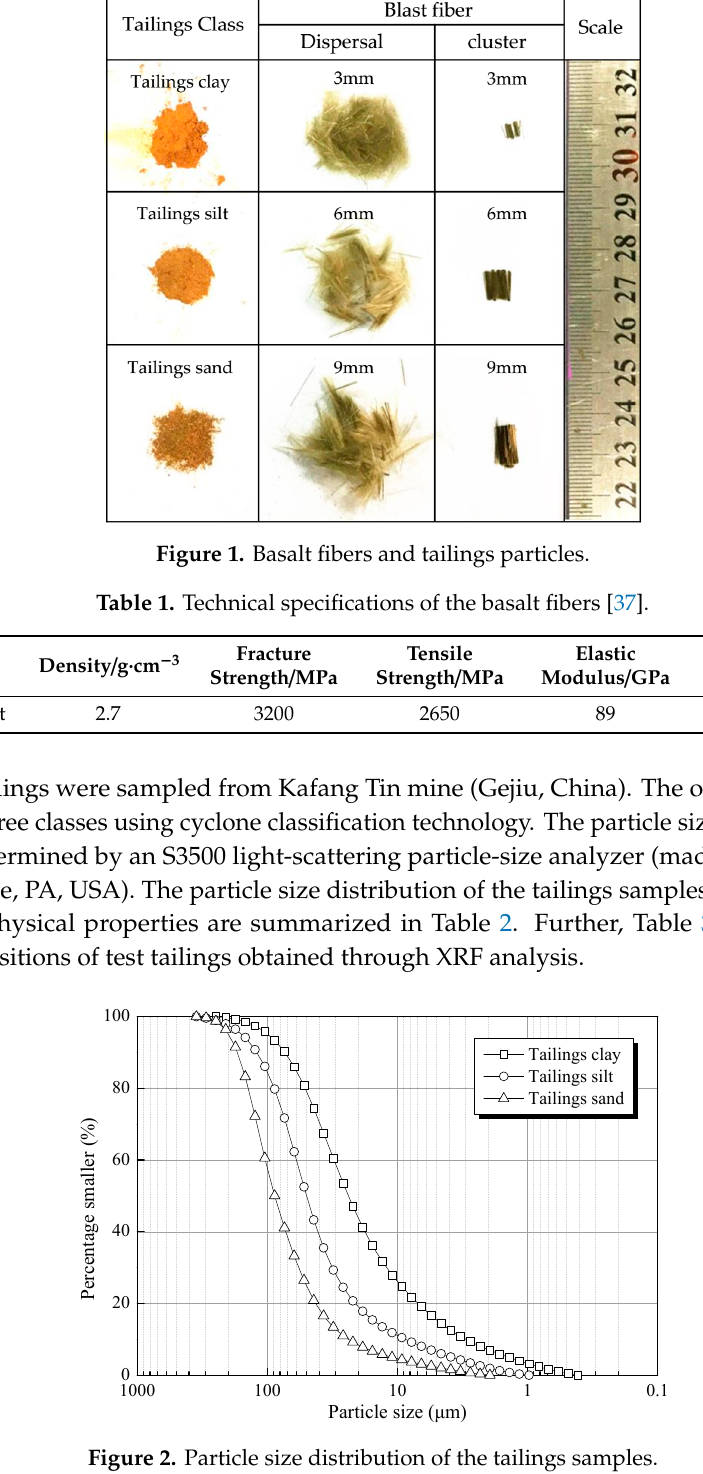
Figure 2. Particle size distribution of the tailings samples.